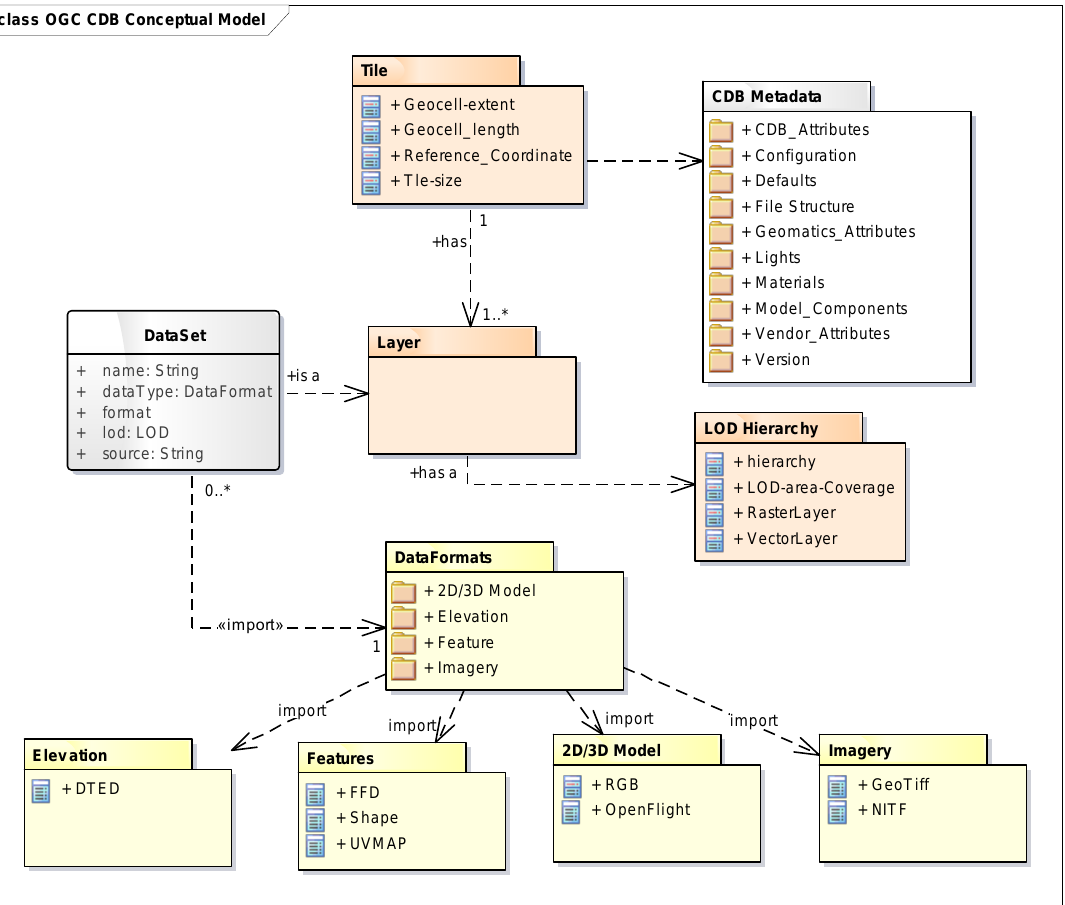
Figure 2. UML Package diagram of the OGC CDB datastore conceptual model [15].